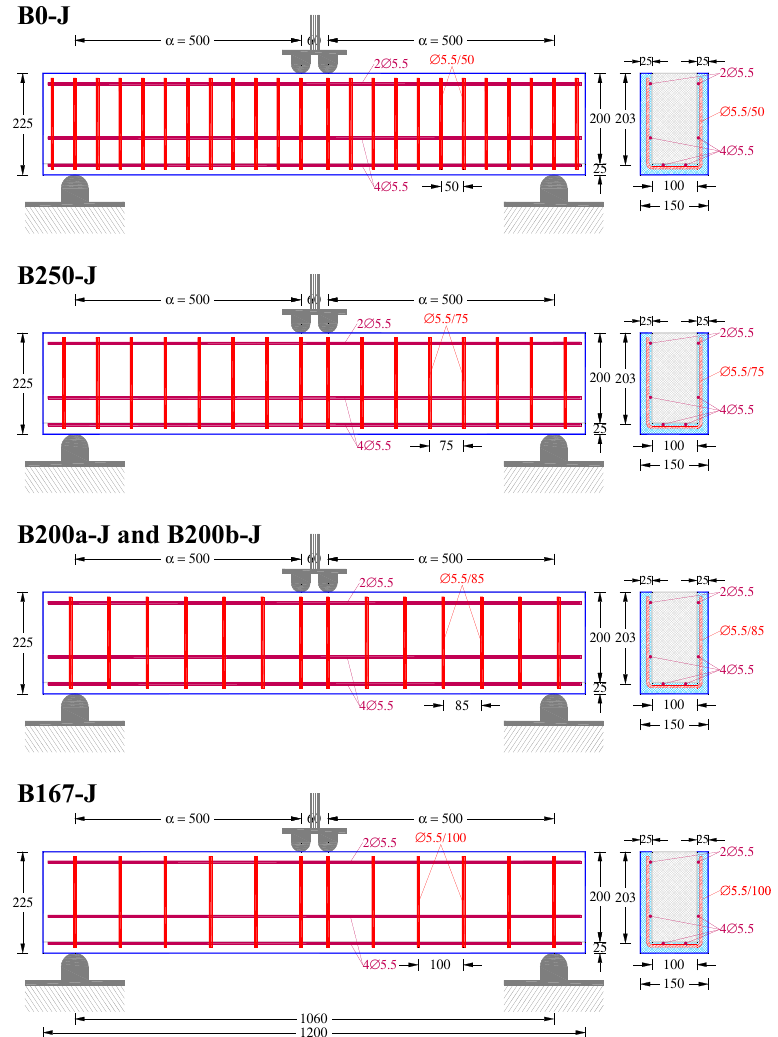
Figure 4. Geometrical characteristics and steel reinforcement arrangement of the jackets of the retrofitted beams (dimensions in mm).